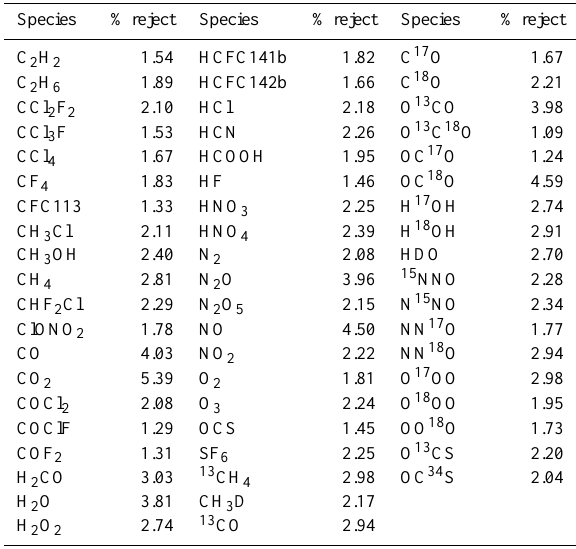
Table 1. Percent rejection of ACE-FTS level 2 v3.5 profiles that contain one or more detected unnatural outlier (either by running MeAD or EDF).